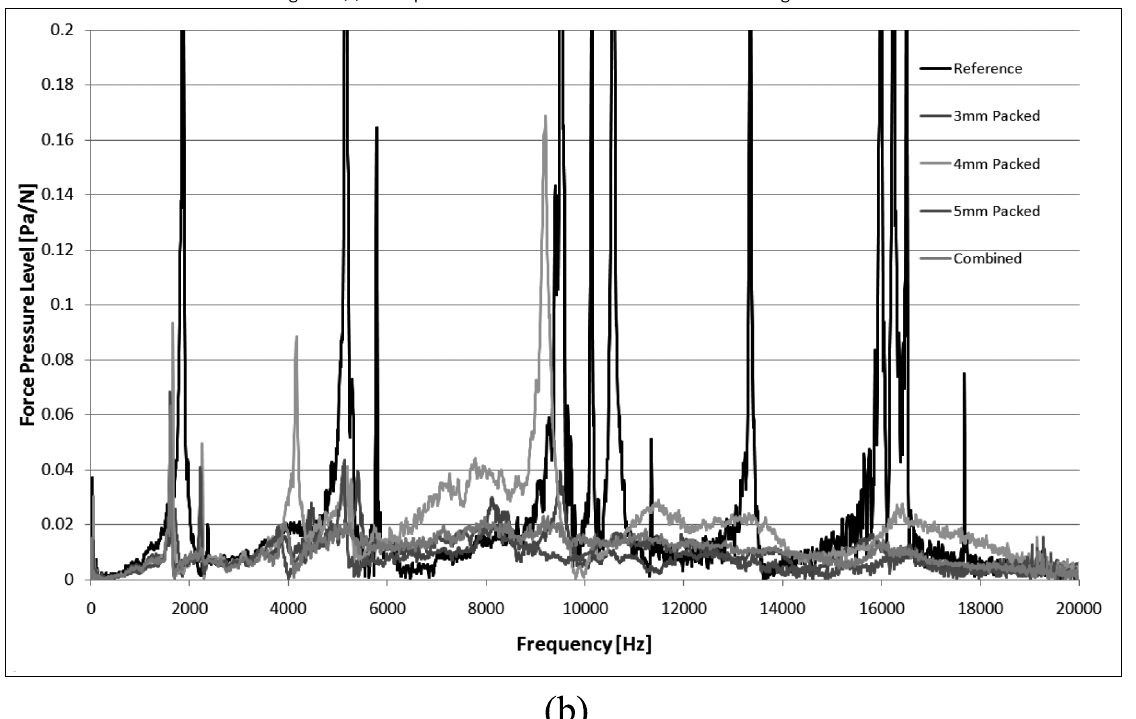
(b) Fig. 71. (b) Microphonics measurements for Packed EIDL configurations- zoom